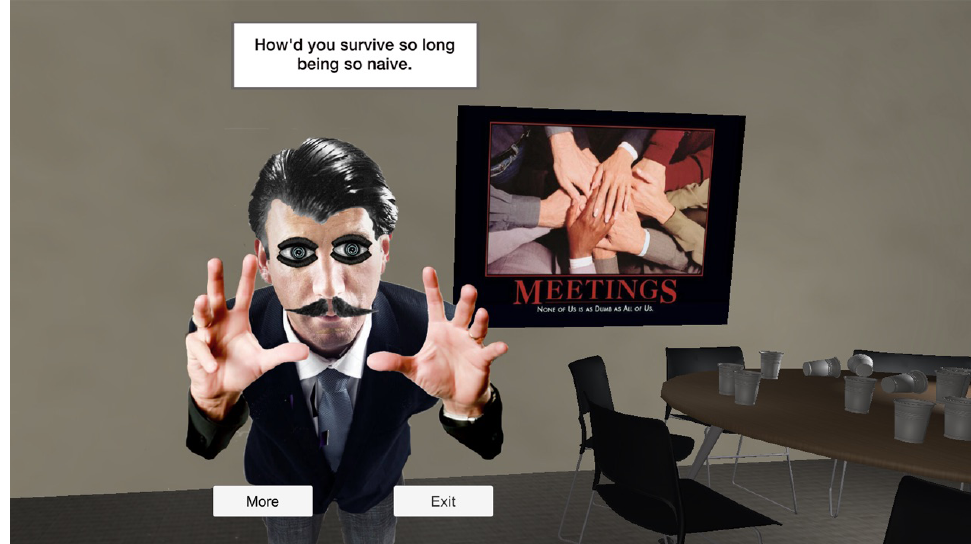
Figure 7. Still from Psychasthenia 3: Dupes . Courtesy of the